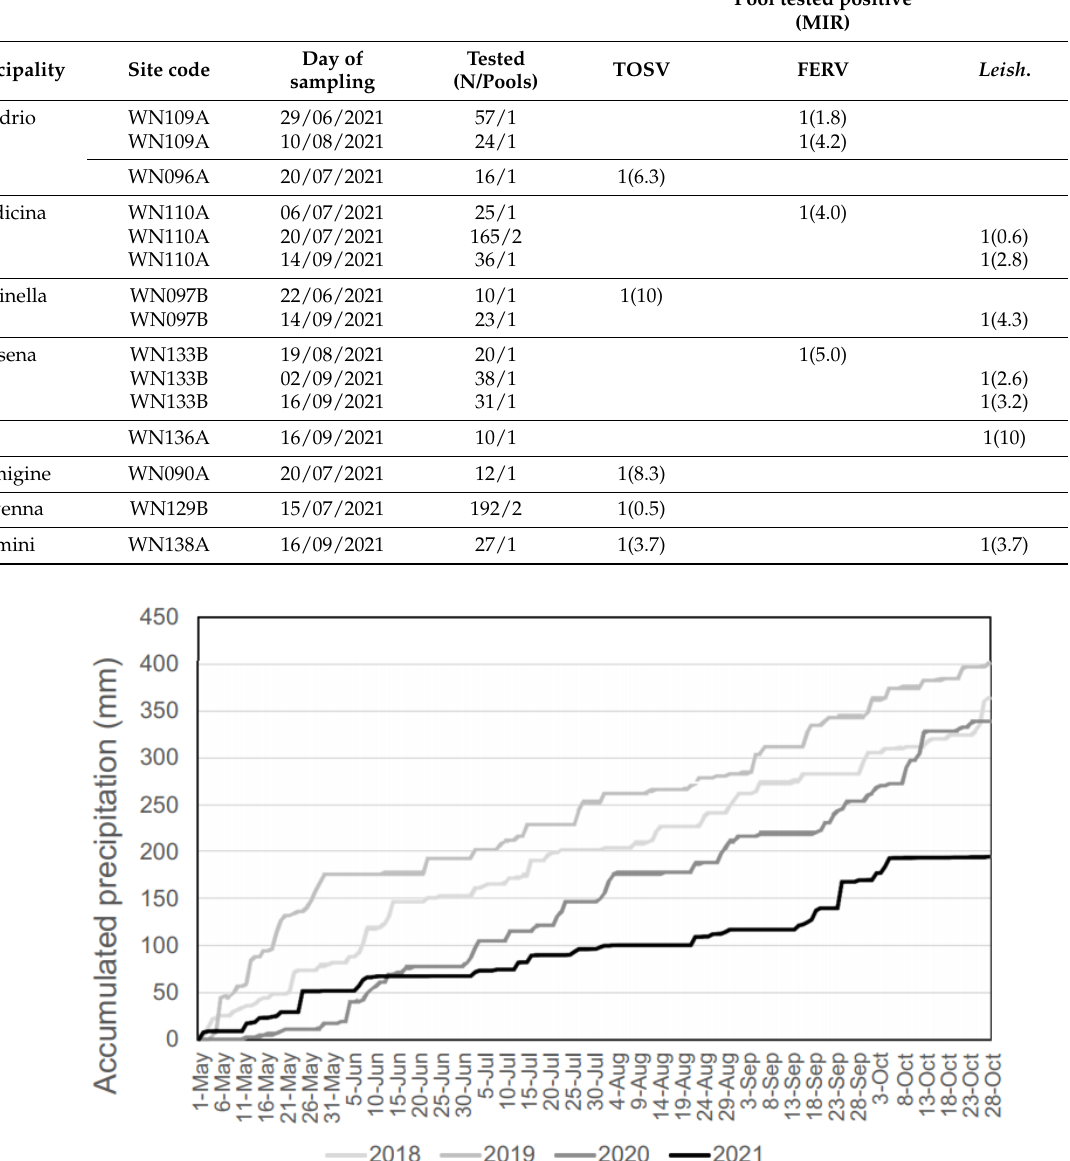
Table 3. Pools that tested positive to the different pathogens, with reference to the minimum infection rate (MIR), by province and municipality and day of sampling.